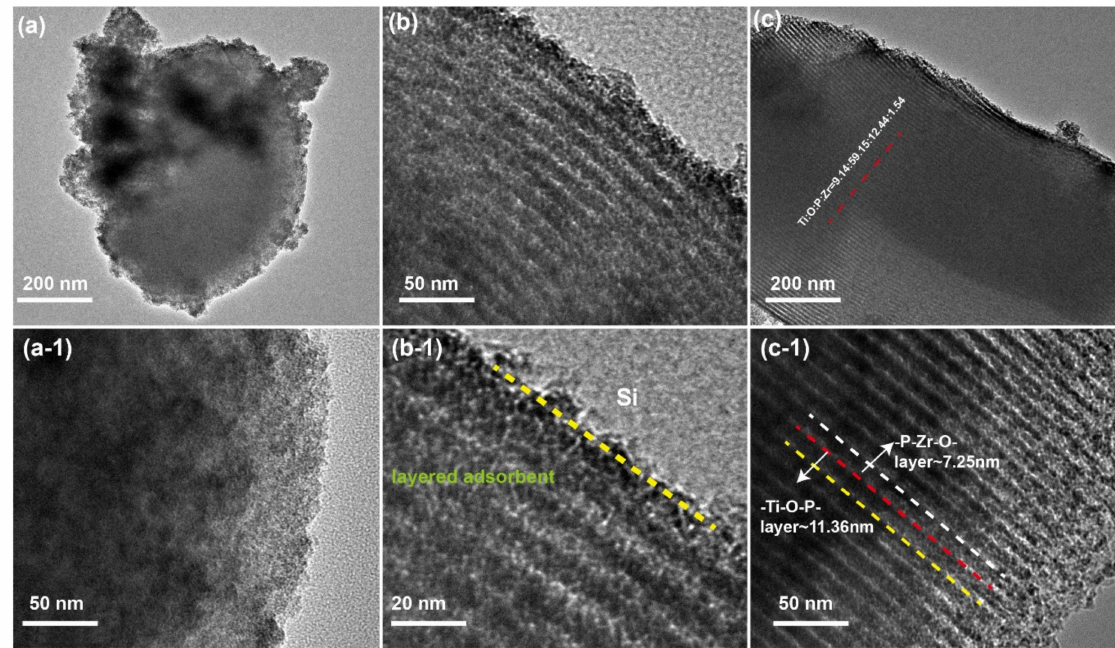
Figure 2. TEM micrograph of ( a ) the SBA-15 and ( a-1 ) magnified image of SBA-15, ( b ) cross-section image of SiO 2 -Ti-P-Zr adsorbent, ( b-1 ) magnified image of cross-section image, ( c ) the SiO 2 -Ti-P-Zr adsorbent, and ( c-1 ) the magnified image of SiO 2 -Ti-P-Zr